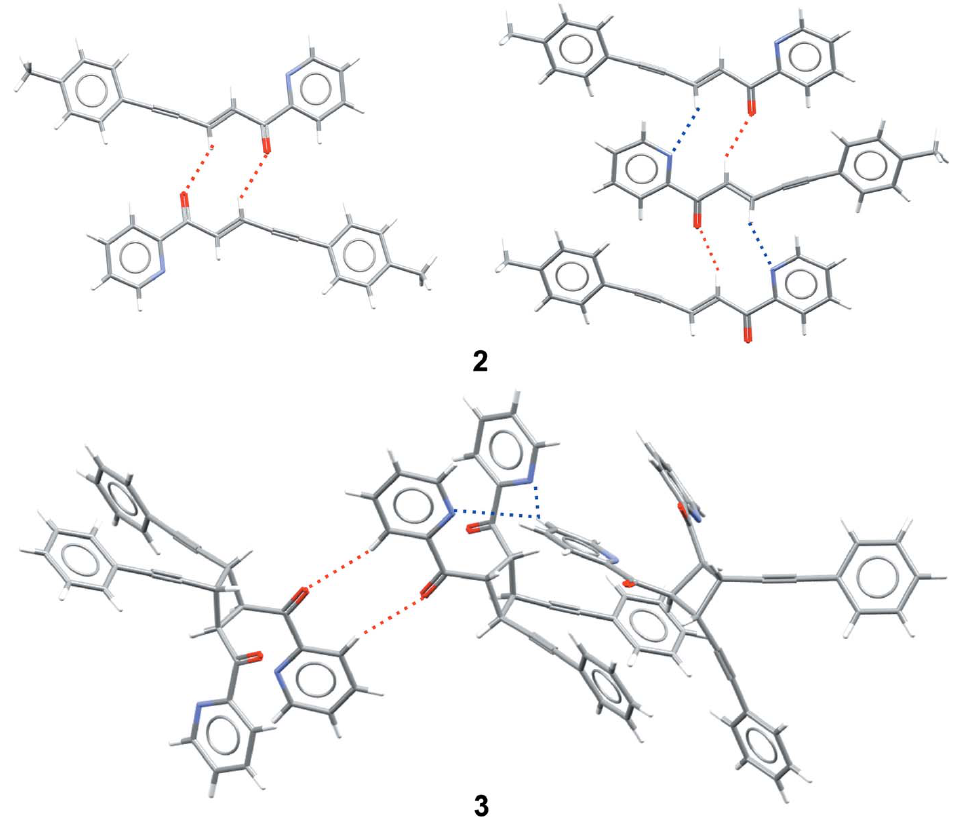
Figure 3 Supramolecular aggregates in the crystals of 2 and 3 . Hydrogen bonds are depicted by dashed lines.